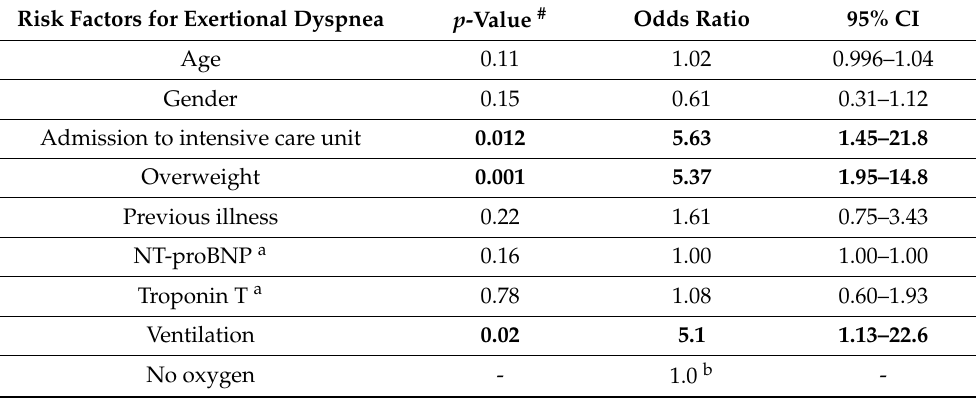
Table 4. Risk factors for developing exertional dyspnea or fatigue after hospital admission due to COVID-19